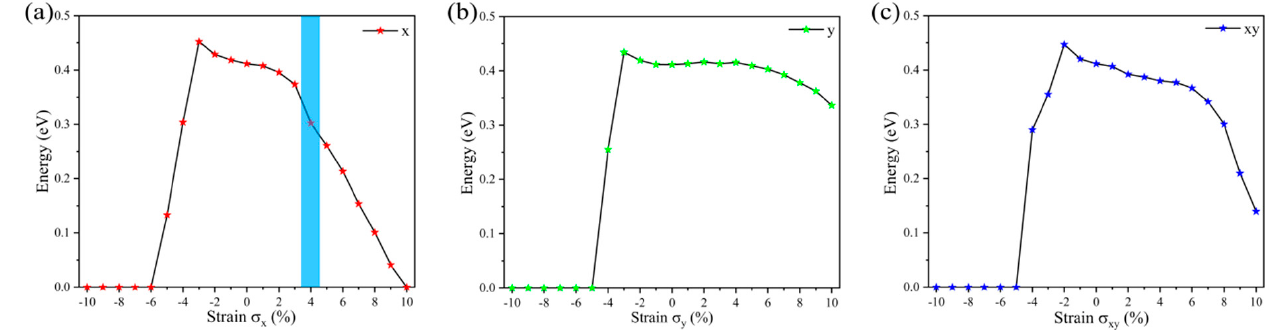
Figure 5. Band gap along with the applied in-plane strain σ in the α -AsP/ γ -AsPhomojunction, with ( a ) strain along x (zigzag) direction, ( b ) strain along y (armchair) direction, and ( c ) biaxial strain.